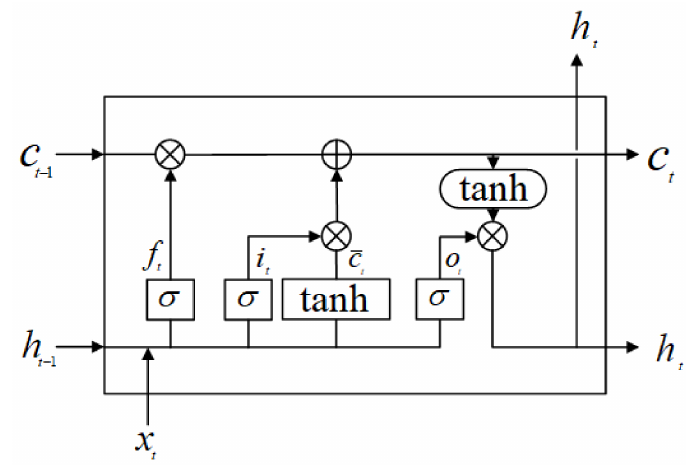
Figure 1. Long Short-Term Memory (LSTM).